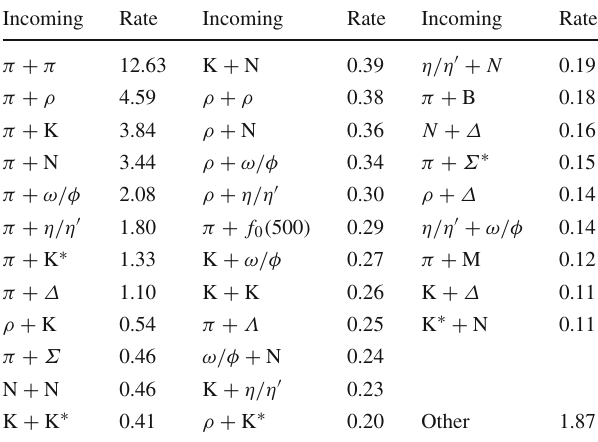
Table 9 Number of collisions per 13 TeV nondiffractive pp event, of different incoming particle combinations, where particles have been grouped so as to avoid too fragmented a view. M represents other meson species and B other baryon ones. All combinations with a rate below 0.1 have been summed into the “other” group